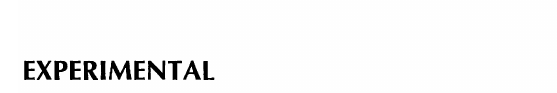
FIGURE 1 Schematic of the EBT fixture.